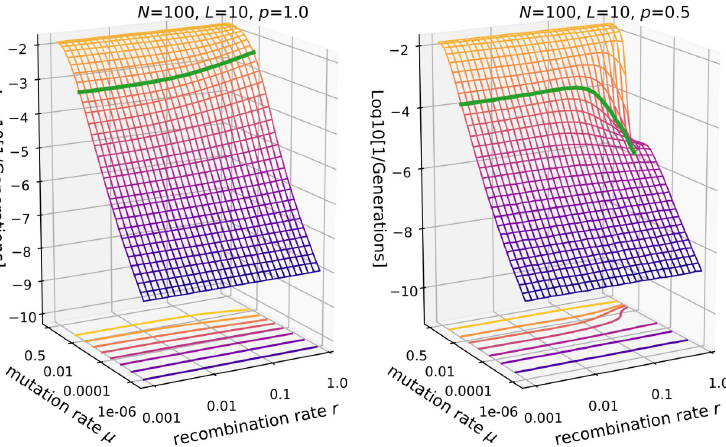
Fig 11. Reciprocal of the time to full discovery in the fsm . Parameters are N = 100, L = 10 and p = 1 (left panel) vs. p = 0.5 (right panel). The green line is drawn at Lμ =